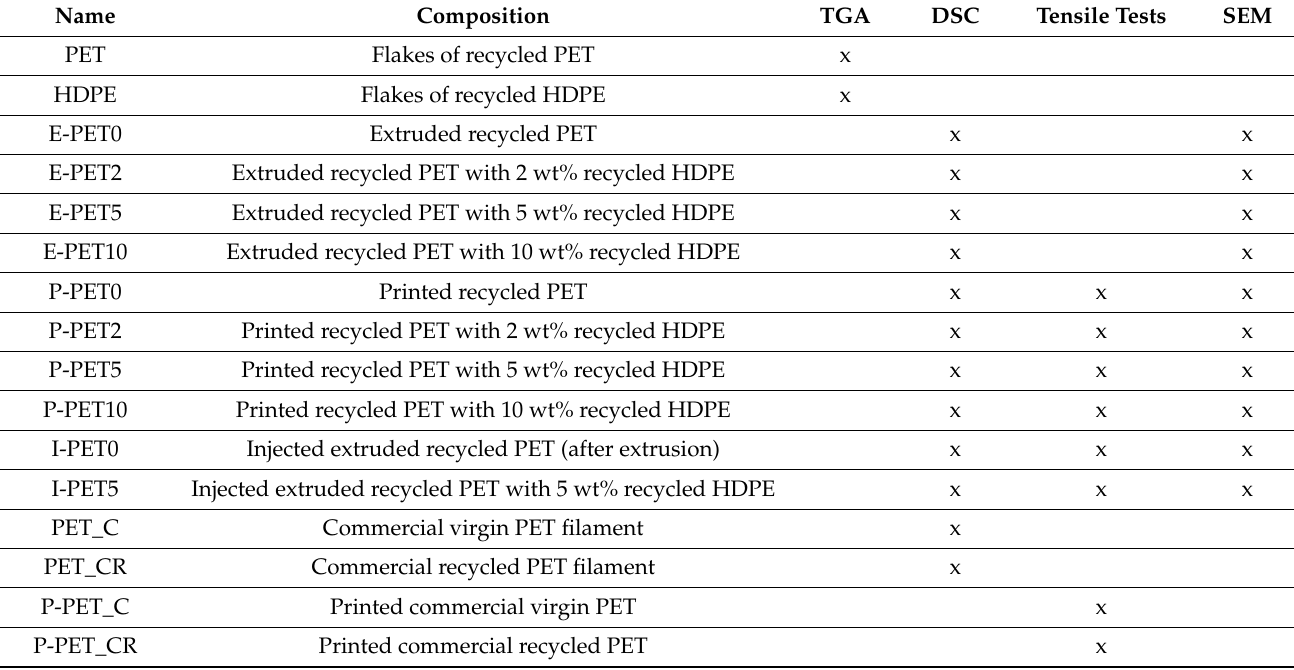
Table 2. Summary of preparations and